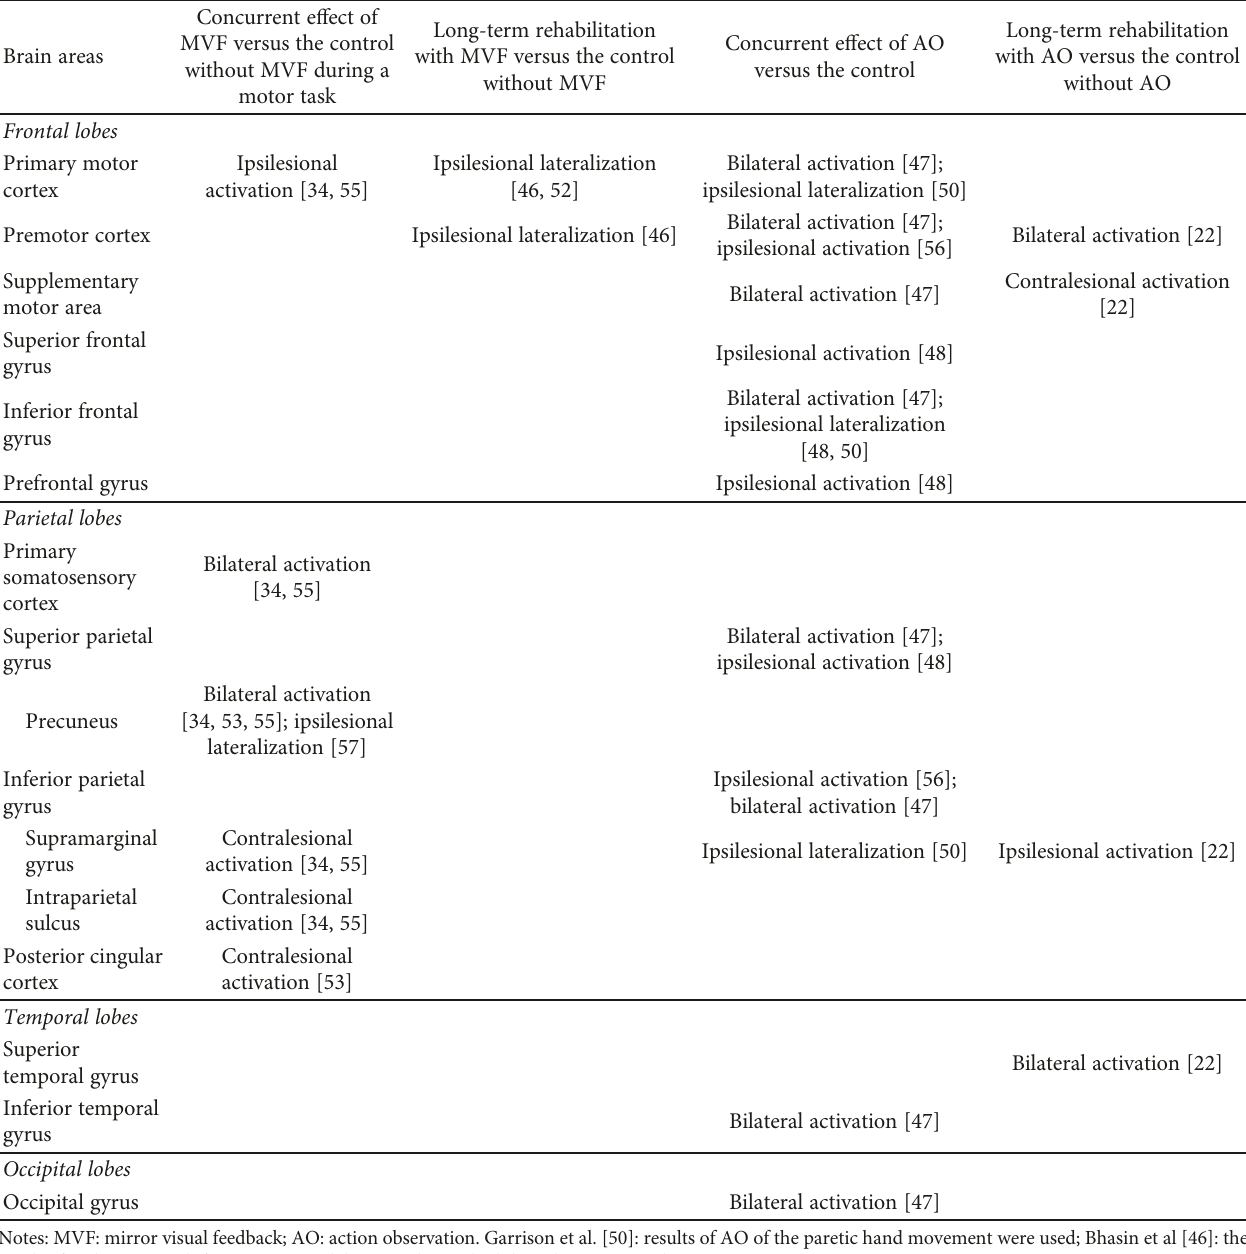
Table 2: Brain activation or lateralization of brain activation measured by